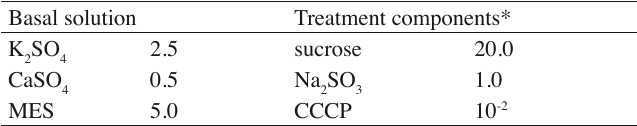
Table 1 - Composition of the basal solution (B.S.) and concentration of the components in the treatments Basal solution Treatment components* SO 2.5 sucrose 20.0 K 2 4 0.5 Na SO 1.0 CaSO 4 2 3 MES 5.0 CCCP 10 -2 All solutions were adjusted to pH 5.5 by way of TRIS or dilute H SO 2 4 when Na SO was present. MES: 2-N-morpholinoethane-sulphonic 2 3 acid (Sigma); CCCP: Carbonyl cyanide m-chlorophenylhydrazone (Sigma); TRIS: 2-amino-2-hydroxymethyl-1,3-propanediol (Fluka). *Concentrations are in mol m -3